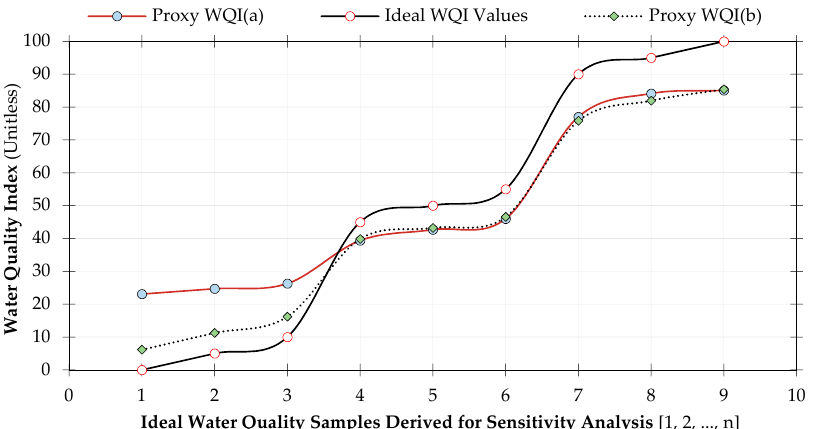
Figure 9. Plot diagram showing the results of the scenario-based analysis of the developed proxy water quality indices (a) and (b) against ideal water quality values derived from nine probable scenarios. The nine cases presented herein, are similar to those applied for UWQI and they are represented as samples 1, 2, …, n , which corresponds respectively to water quality (WQI) values of 0, 5, 10 (worst-cases); 45, 50, 55 (base cases); and 90, 95, 100 (best cases).